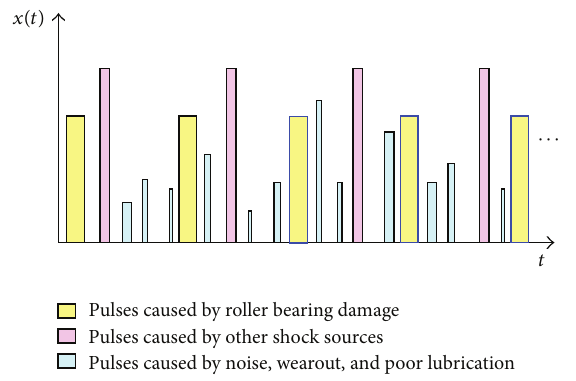
Figure 2: Schematic diagram of shock pulses extracted by SPM.